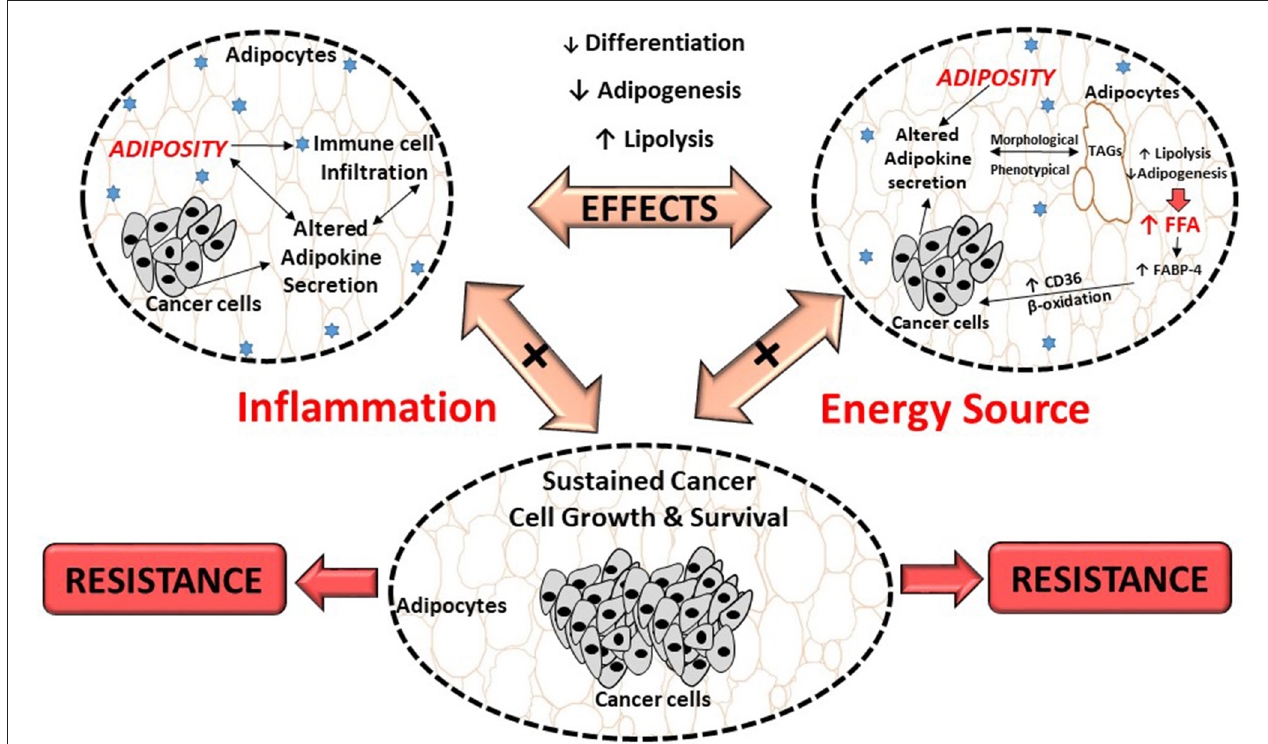
FIGURE 2 | Proposed effects of breast cancer cells on adipocytes and its role in treatment resistance. Breast cancer cells dysregulate metabolic pathways, by altering the secretion of adipokines from adipocytes which results in inflammation. This, could result in morphological and phenotypical changes (delipidation) and thereby increase the release of FFA. These FFA provide energy substrates for cancer cells to sustain its high proliferation demand, contributing to cancer treatment resistance. FABP-4, fatty acid binding protein-4; FFA, free fatty acids; TAGs, triglycerides; CD36, fatty acid translocase.